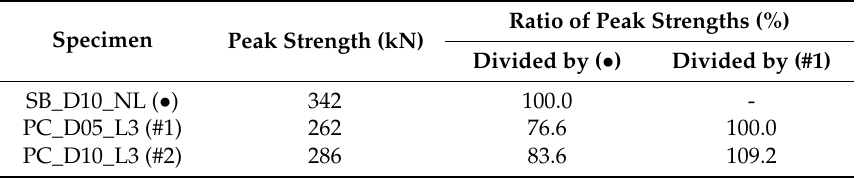
Table 7. Effect of infilled concrete depths for PO_L3 specimens.